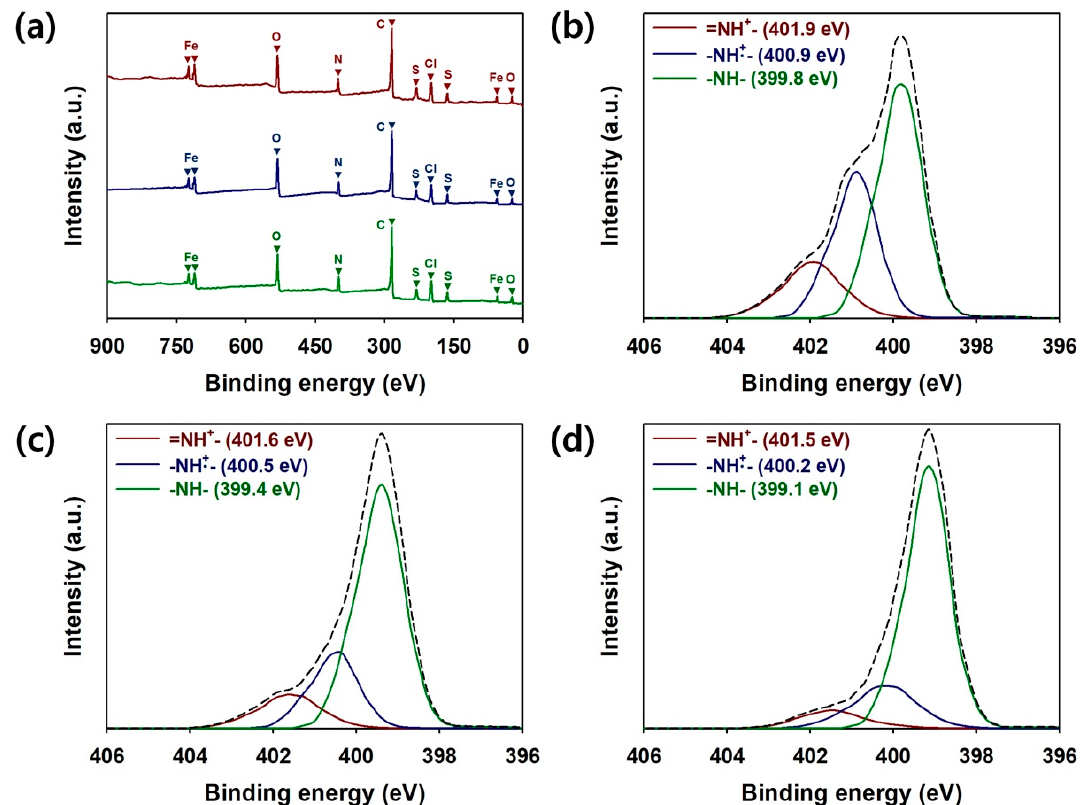
Figure 3. ( a ) The fully scanned X-ray photoelectron spectroscopy (XPS) spectra of PPy:PSS with a PSS molecular weight of 1.0 × 10 6 g/mol (PPy100 (red)), PPy:PSS with a PSS molecular weight of 2.0 × 10 5 g/mol (PPy20 (blue)), and PPy:PSS with a PSS molecular weight of 7.0 × 10 4 g/mol (PPy7 (green)). The XPS core spectra in the N(1s) region of ( b ) PPy100, ( c ) PPy20, and ( d ) PPy7.